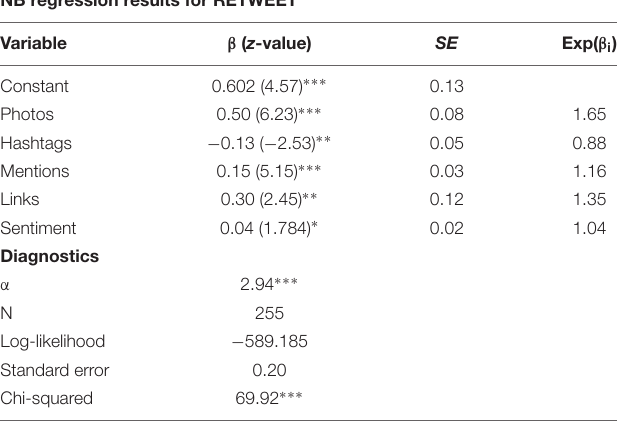
TABLE 7 | Predictor variables presented alongside their z -values and standard errors ( SE ). NB regression results for RETWEET